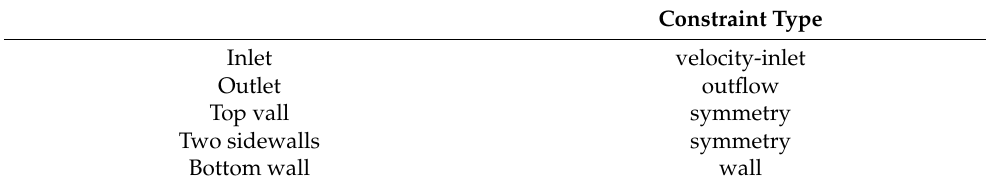
Table 1. 3D model boundary conditions.